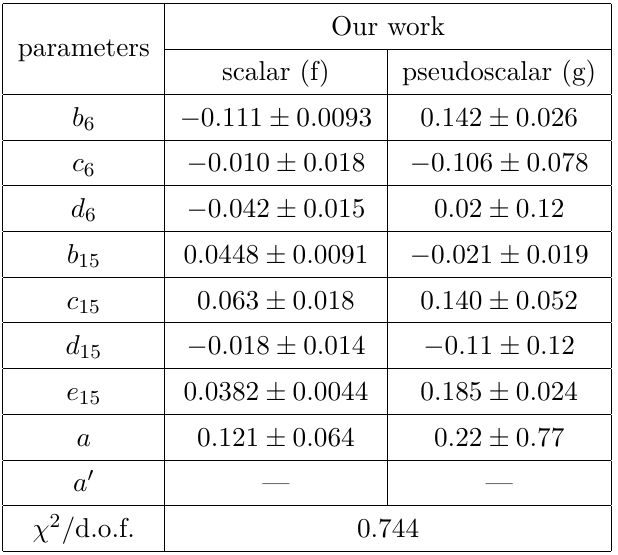
Table 4 . SU(3) symmetry irreduciable amplitudes from fitting.